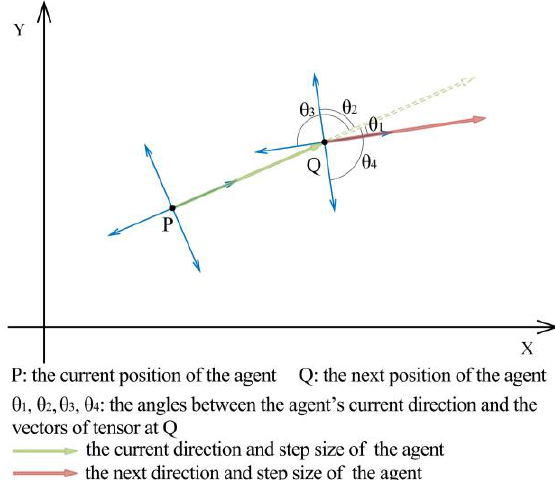
Figure 5. Basic moving rules of agent in tensor field